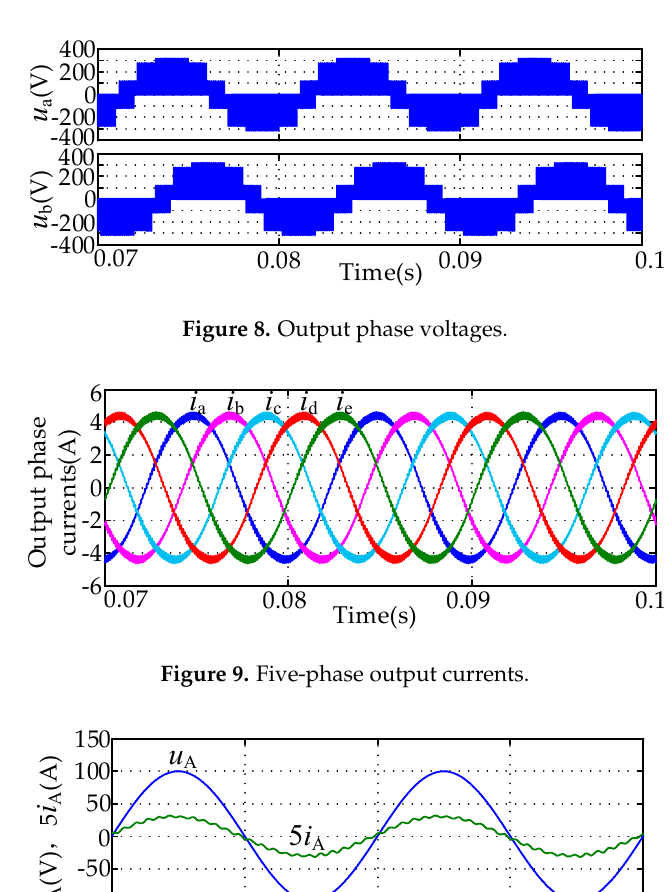
Figure 7. Spectrum analysis of u ab .